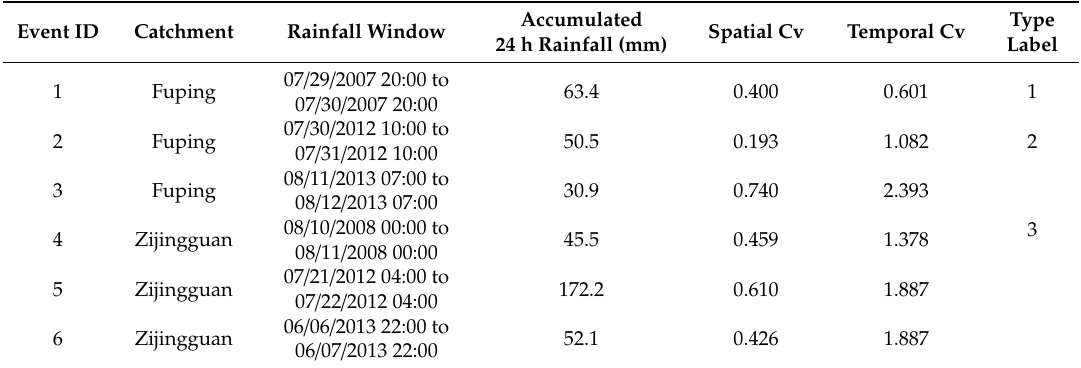
Table 1. Storm events selected from the two study catchments and their spatiotemporal rainfall evenness characterized by